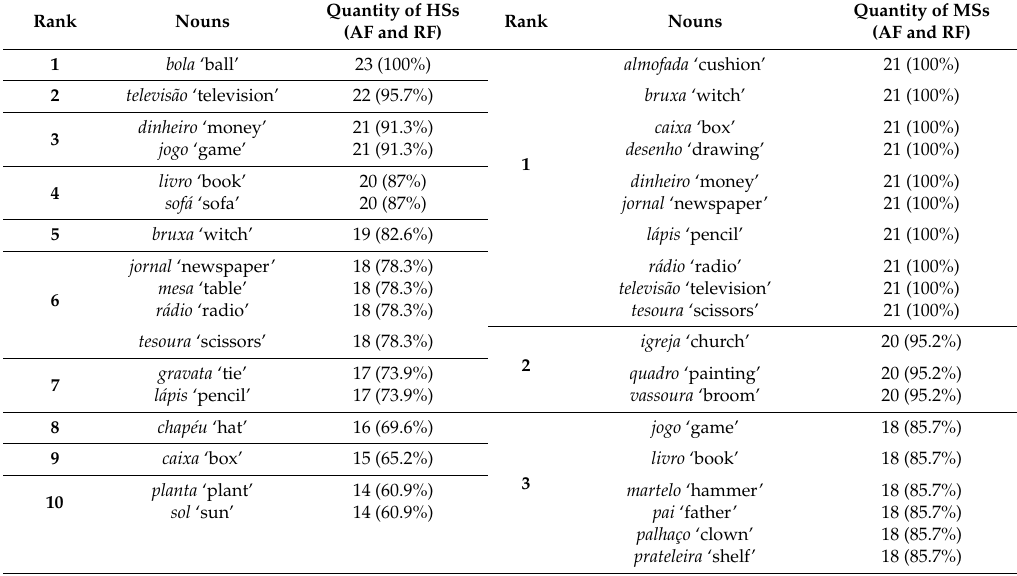
Table A3. Nouns, verbs and adjectives with the 10 highest frequencies per group of